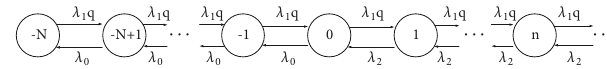
Figure 4: State transition diagram for the fully unobservable